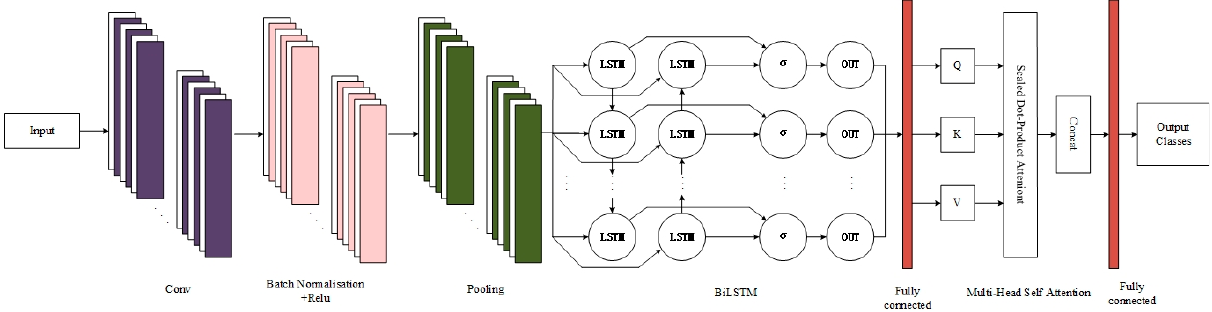
Figure 2. The proposed CNN-BiLSTM-MHSA classification framework.